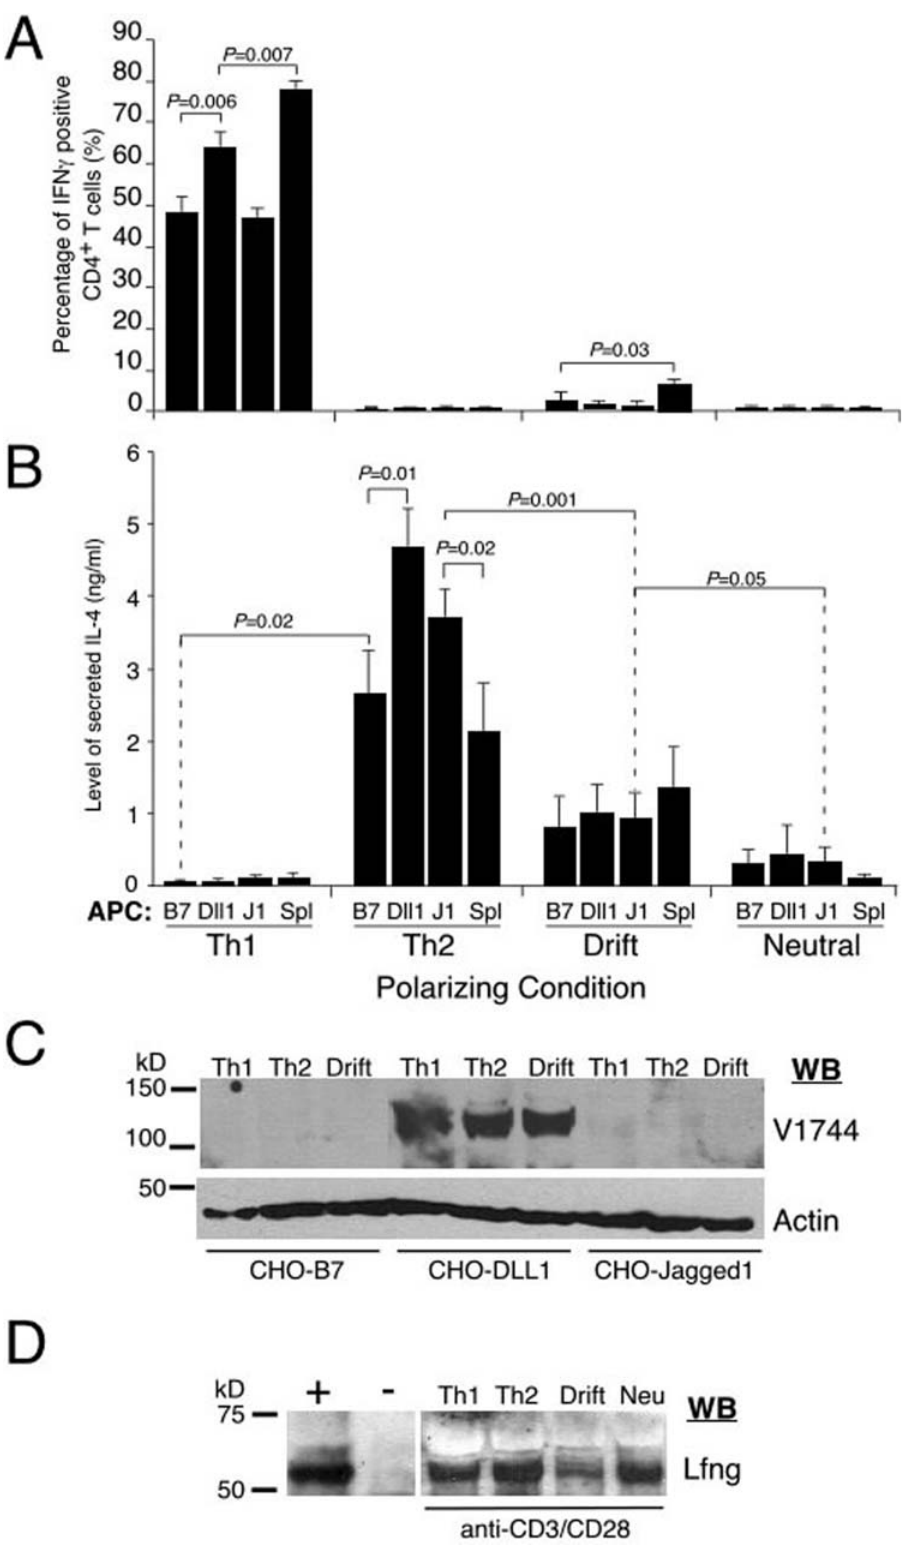
Figure 2. Notch ligands cannot instruct Th1/Th2 differentiation in the absence of inducing cytokines but only act selectively in co- stimulation. (A) Notch ligands cannot induce a Th1 program under ‘‘drift’’ or ‘‘neutral’’ conditions, whereas only DLL-1 enhances IFN- c production under Th1 polarizing conditions. Naı¨ve CD4 + T cells from DO11.10 mice were purified to . 99% purity by a two-step protocol, and primed with different APC lines and 0.3 m M OVA peptide in 4 polarizing conditions for 2 days. Activated T cells were expanded in fresh media for another 5 days, re-stimulated with 4 h of PMA/Ionomycin and stained for intracellular IFN- c . B7: CHO-B7, DLL1: CHO-DLL1, J1: CHO-Jag1 and Spl: BALB/c spleen cells.